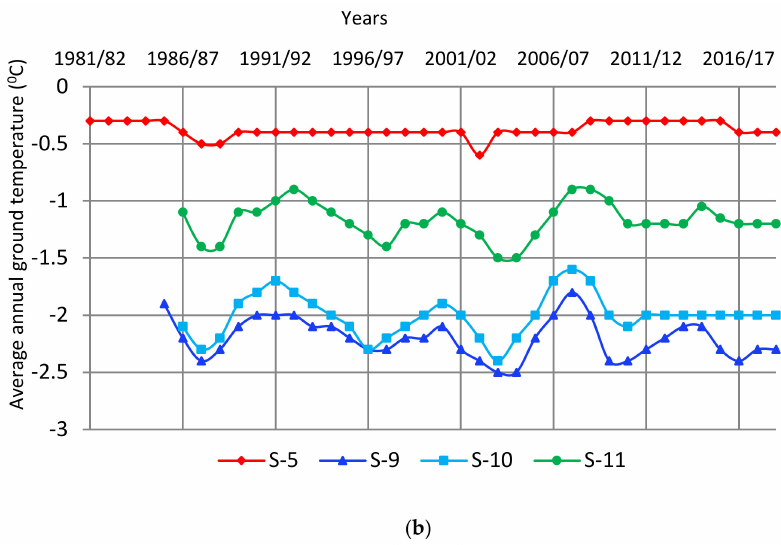
Figure 6. Long-term variability of ground temperatures at the base of the active layer ( a ) and at a depth of 10 m ( b ) in sthe lope type of terrain at the Chabyda station.